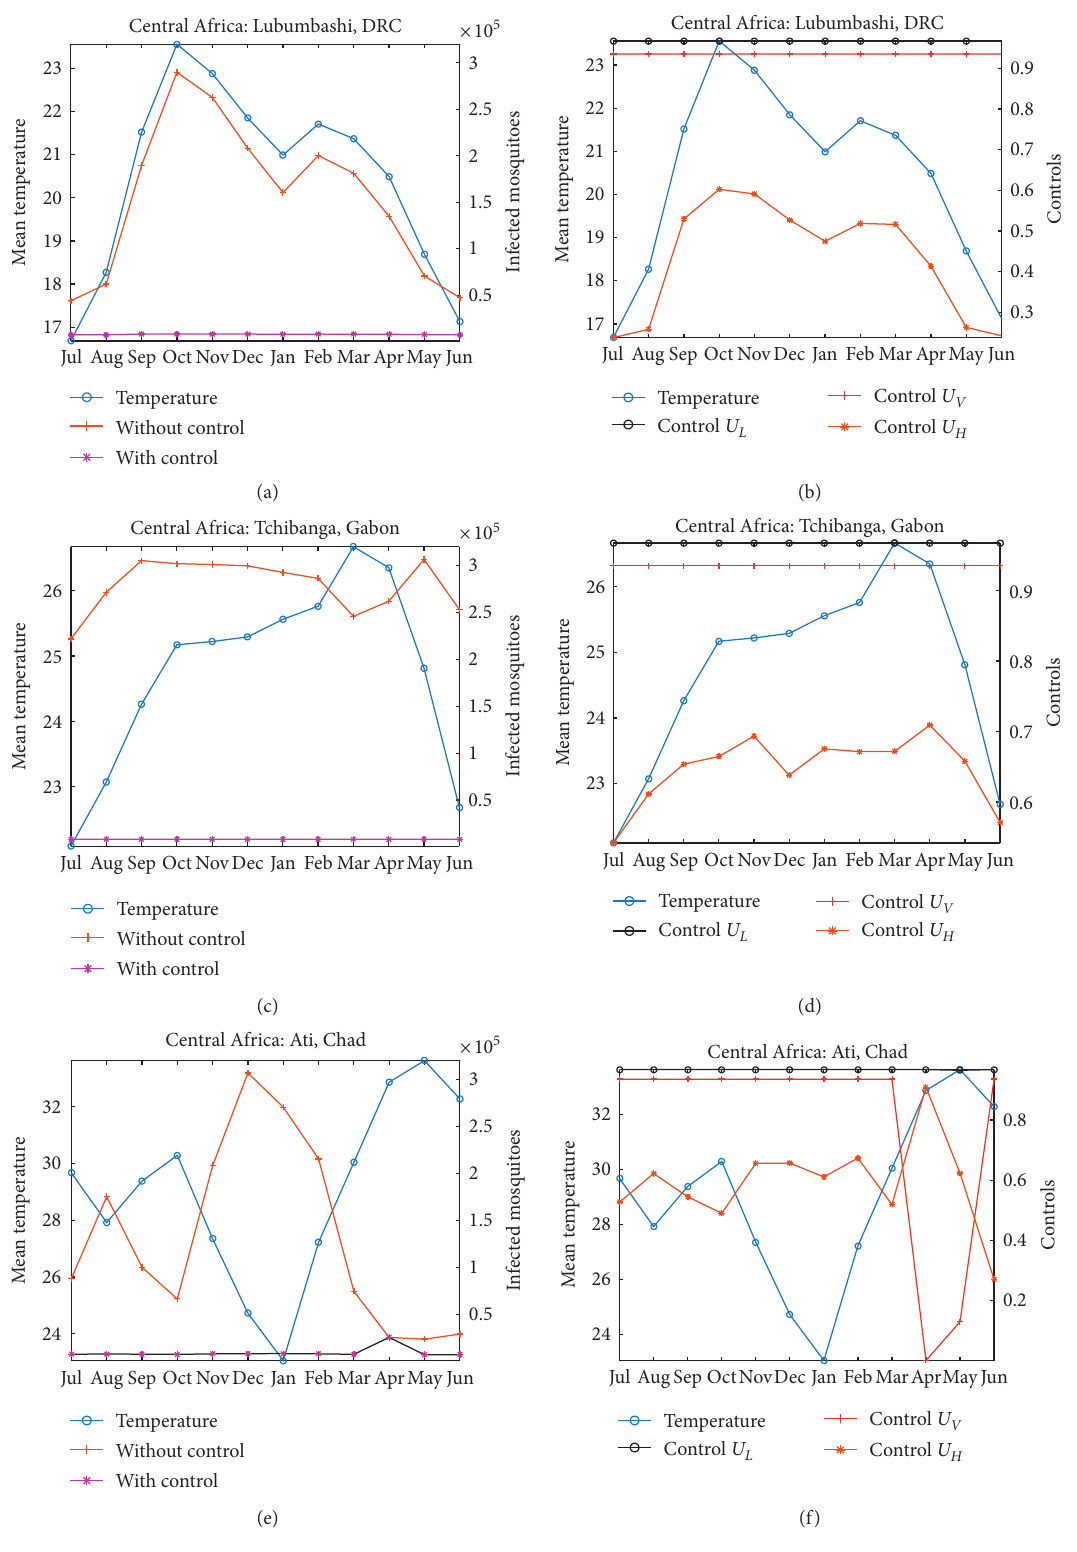
Figure 9: Simulations of the model (2) as a function of time: (a, c, e) the monthly total number of infected mosquitoes without and with control and (b, d, f) optimal controls u H ( t ) , u L ( t ) , and u V ( t ) , in Lubumbashi, DRC; Tchibanga, Gabon; and Ati, Chad; in Central Africa. The mean monthly temperature is plotted in blue lines and is superimposed onto each